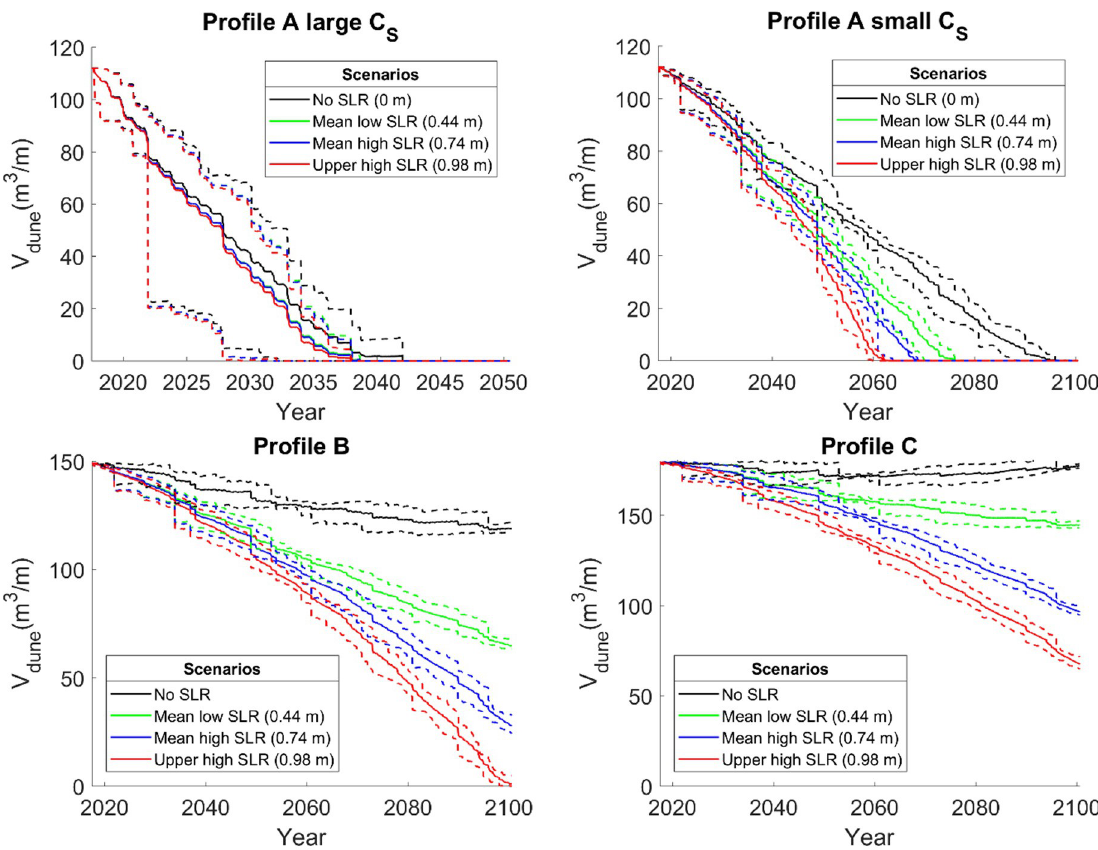
Fig 16. Simulated dune volume evolution. Solid lines represent mean value, and the dashed lines represent min and max values from the 10 simulations for each scenario.